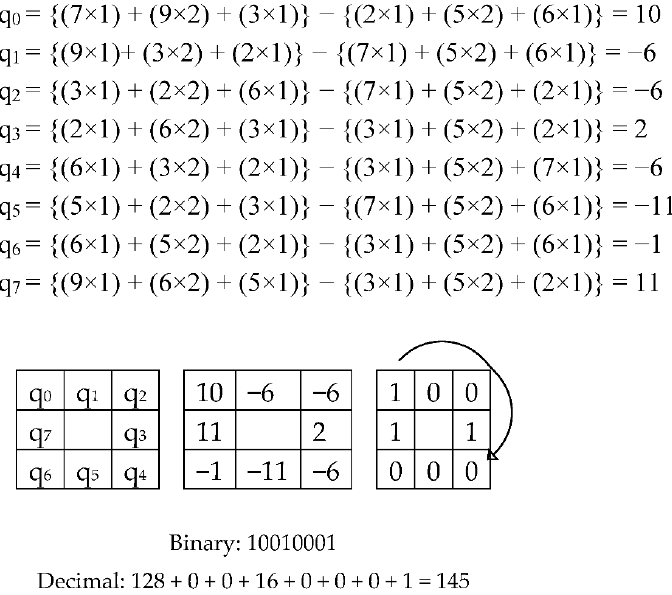
Figure 7. Calculation of LBP (8, 1) .